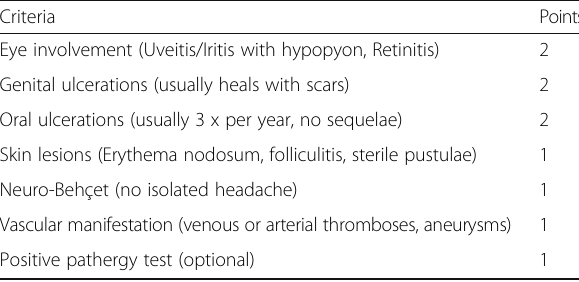
4 Points: possible, 5 Points: very probable, 6 Points: almost certain diagnosis (94% sensitivity, 90%